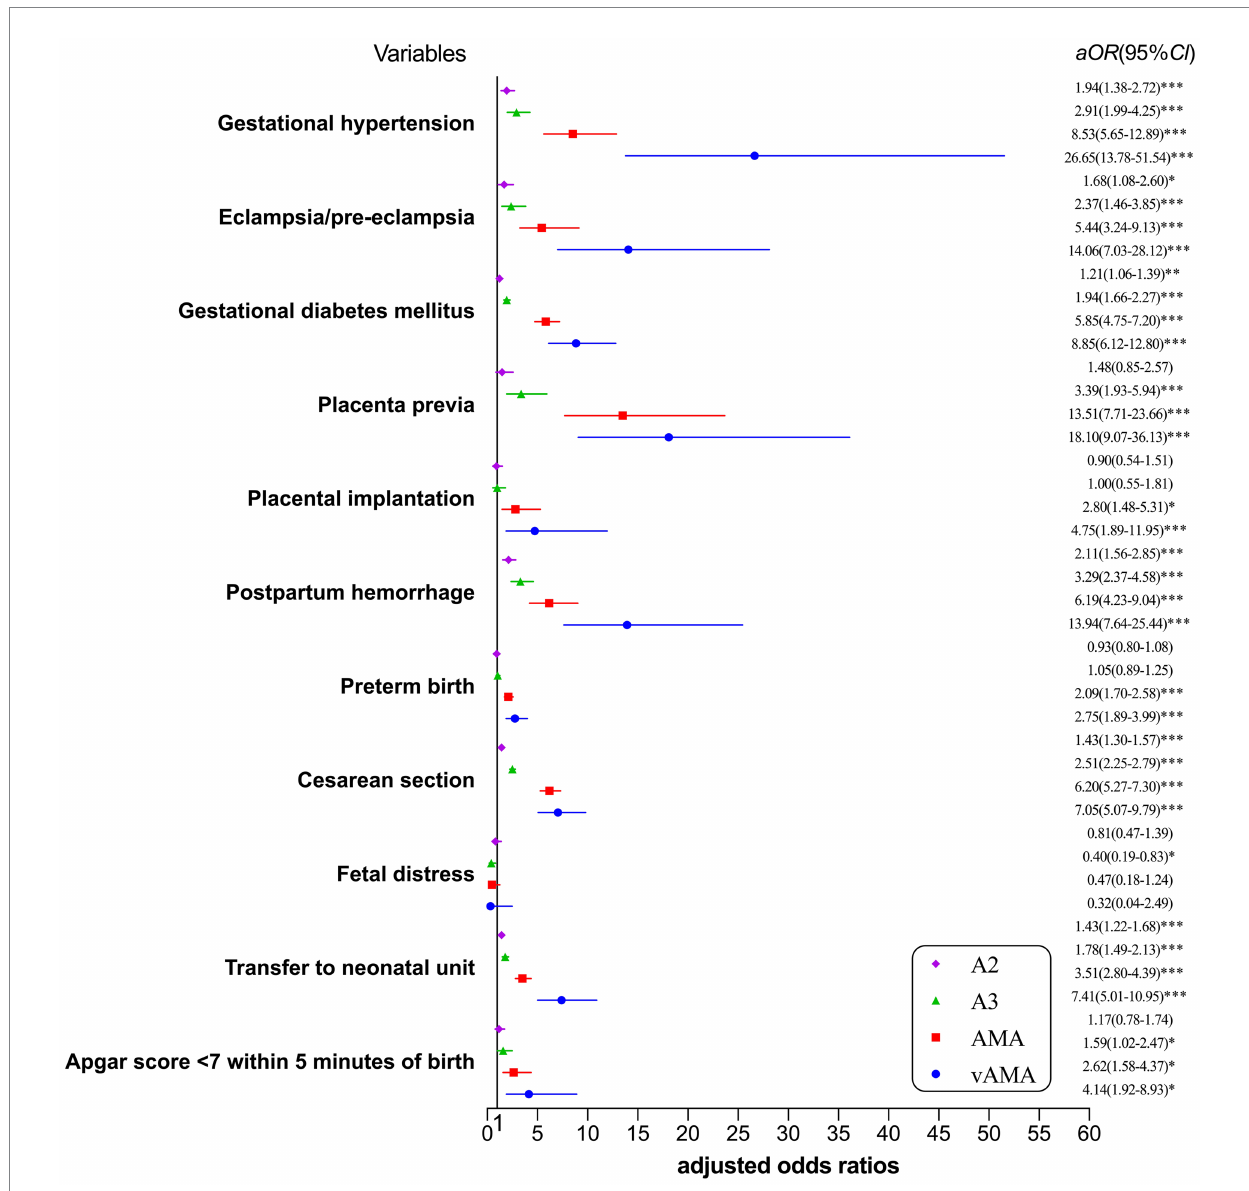
FIGURE 1 Forest plot for risk of adverse pregnancy outcomes and neonatal outcomes by single age group. * p < 0.05, statistically difference, ** p < 0.01, statistically significant difference, and *** p < 0.001, highly statistically significant